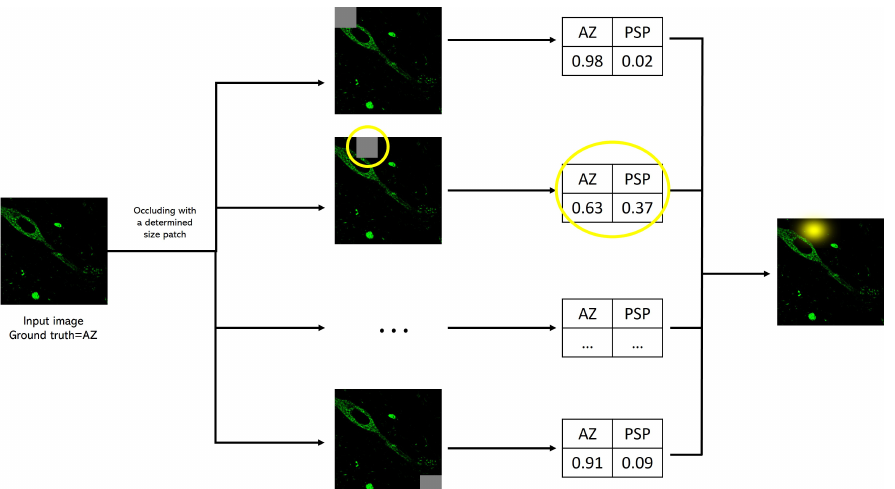
Figure 5. Occlusion sensitivity study diagram. The input image enters the previously trained classifier; then, a patch is placed covering a certain part of the figure and a prediction score is made. The process of placing a patch in another region of the image and generating a score continues until the patch has been placed throughout the image. Regions where the prediction score changed considerably are highlighted with a yellow